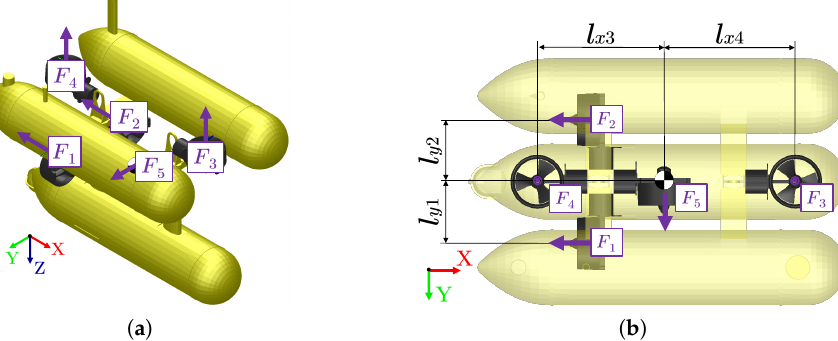
Figure 3. Considered AUV with its five-thruster configuration: ( a ) Thrust forces directions, ( b ) Distances from AUV center of mass to